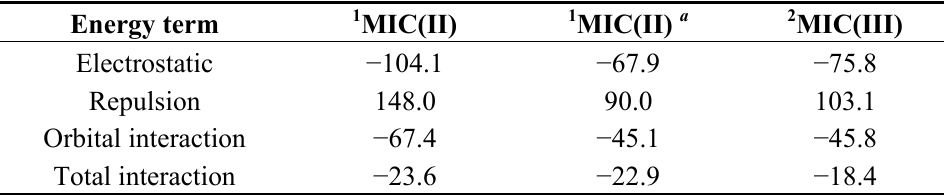
Table 2. Summary of B3LYP/TZP-EDA-derived energy terms for several MICs (in